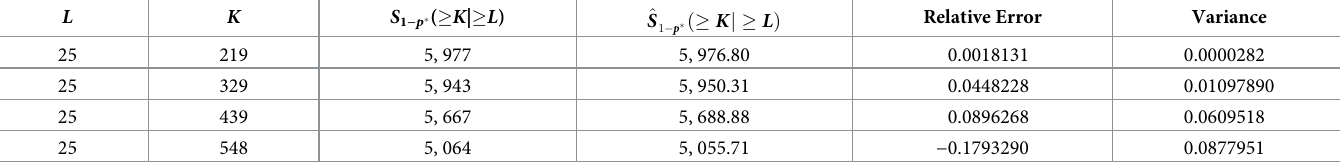
Table 2. Percentage errors for popularity change predictions in Twitter database. For a fixed L = 25 and different values of K (first and second column), we estimated, from ten different Twitter sub-samples ( p � = 5%), the number of species having abundance at least K at the unobserved scale 1 − p � = 95% given that they have abundance at least L at the sampled scale p � via estimator (4). The average among the ten sub-samples of the true numbers of species, S 1 and the variance of the relative error obtained in the ten predictions. Similar results have been obtained for other values of L and K (see S4 Table in S1